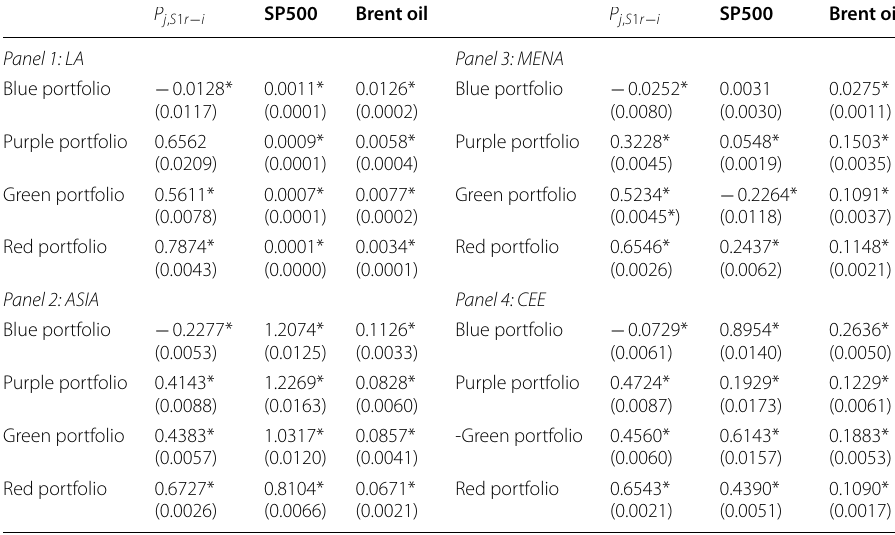
This table presents a long-term relationship for the four emerging market groups, relating to model (3): P it = δ 1 i + θ 1 i P j , S 1 r − i , t + θ 2 i S & P 500 it + θ 4 i Brent it + µ it . The dependent variable, (cid:31) P i , r , is a vector of returns of emerging markets, i , in region r . (cid:31) P j ,1 r − i is a vector of returns of j markets in Blue-Red portfolios, excluding i . Blue portfolio captures correlation between ( i ) and ( j ) markets of 0.2 or lower; Purple portfolio captures correlation between 0.2 and 0.3; Green portfolio covers correlation between 0.4 and 0.5; the Red portfolio stock consists of correlations of 0.6 or more. Brent it is Brent oil price series; and S & P 500 it is the price index of the US market. For results relating to models (1–2 and 4–5) refer to Additional file 1: Tables S6-1 to S6-4. Values in parenthesis are standard errors. * denotes level of significance at 5% or